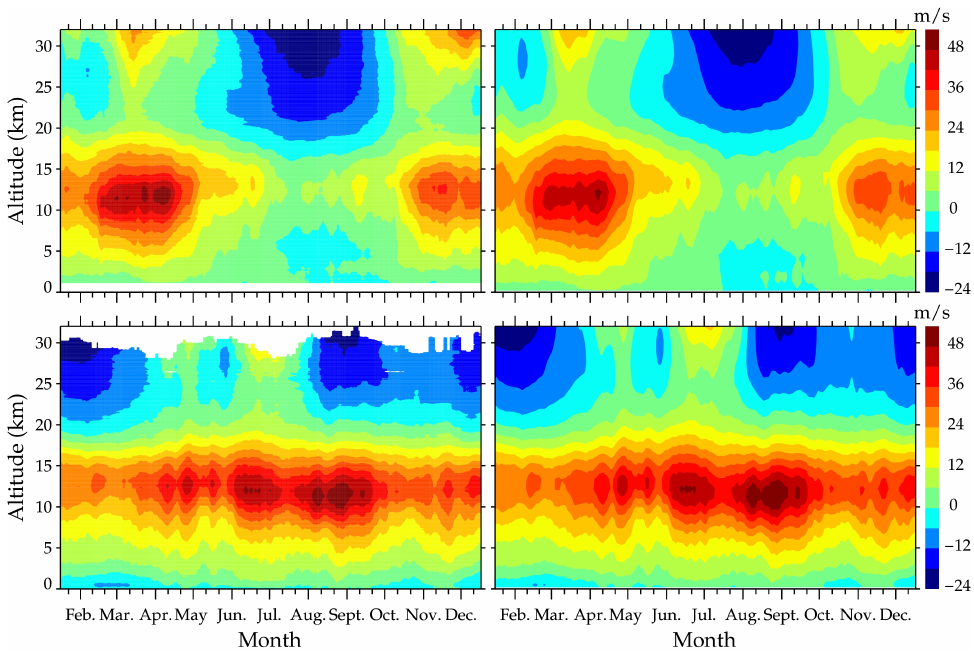
Figure 1. Background zonal winds at Santa Teresa ( top row ) and Perth Airport ( bottom row ) deduced from the radiosonde observations ( left panels ) and MERRA-2 data ( right panels ) in